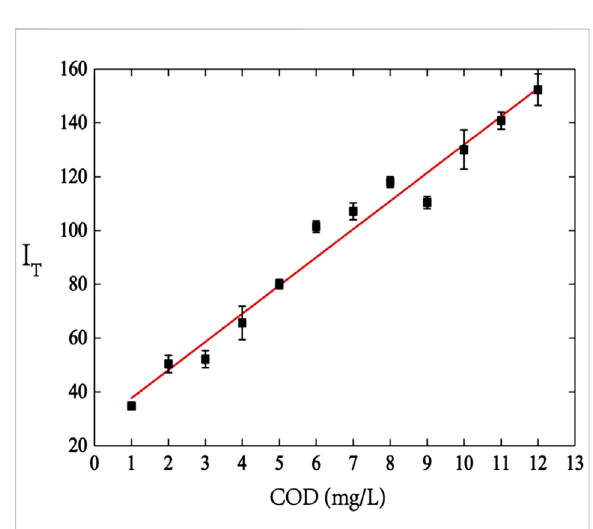
FIGURE 5 The correlation between COD value of standard solution and integrated- fl uorescence-intensity (vertical direction presents COD value of standard solution, horizontal direction presents spectral integrated- fl